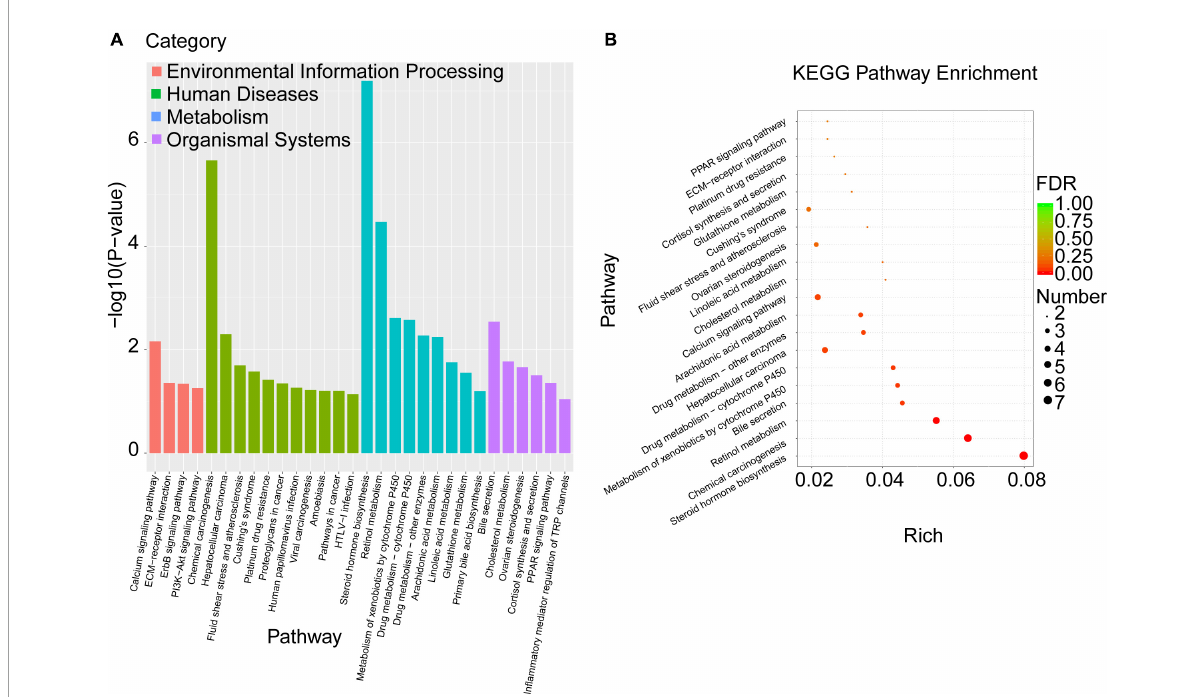
FIGURE6 KEGG pathway enrichment analysis was performed with the overlapped DEGs. (A) The enriched KEGG pathways were clustered into four main categories, including environmental information processing, human diseases, metabolism, and organismal systems, which were further divided into several subcategories. (B) The top 20 significant KEGG pathways of the overlapped DEGs in liver were selected based on the order of p value from small to large.